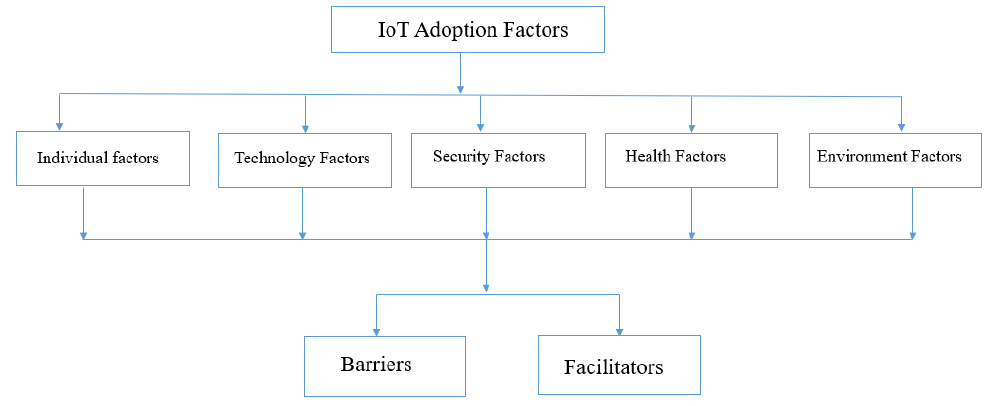
Figure 6. Factors